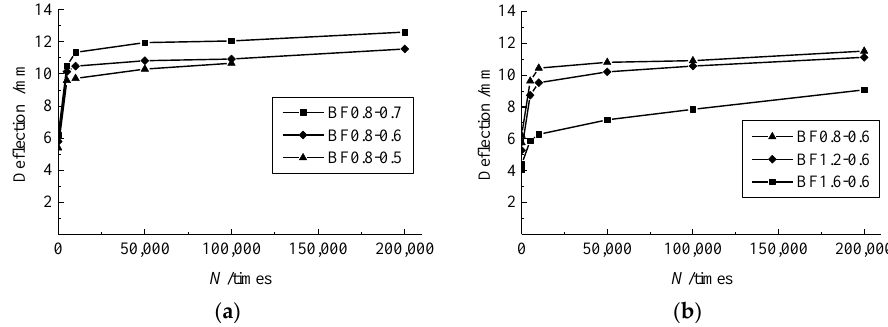
Figure 7. Changes of mid-span deflection affected by: ( a ) α h ; and ( b ) v f .